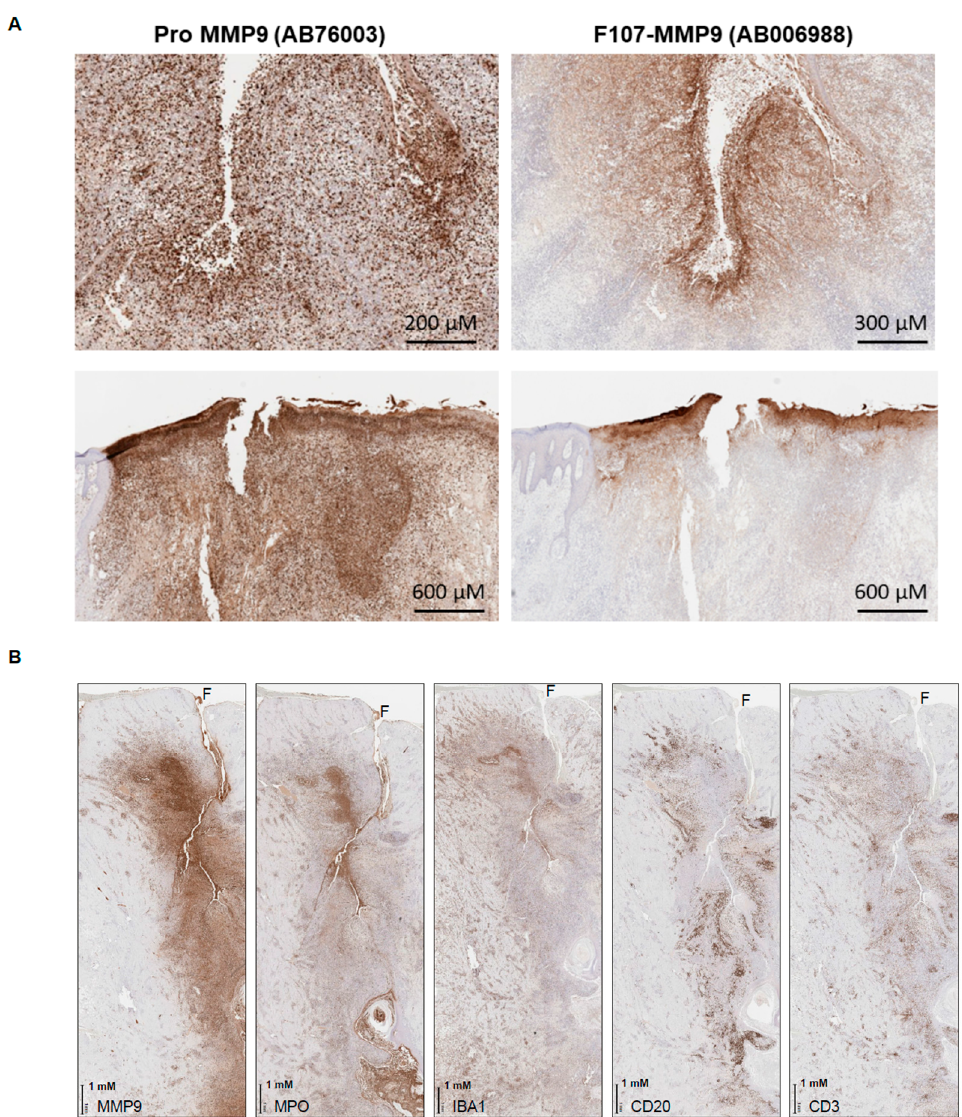
Figure 4. Pro- and active MMP9 in hidradenitis skin specimens. ( A ) Pro-MMP9 is widespread in the skin of patients with hidradenitis, while active MMP9 is more focal and associated with ruptured epidermis (top) and ruptured hair follicles (bottom). ( B ) Active MMP9 and myeloid cells (MPO+ neutrophils and IBA1+ macrophages) are found proximal to the rupture in the skin, while lymphocytes (CD20+ B cells and CD3+ T cells) are secondary. F, fistula; IBA1, anti-ionized calcium- binding adaptor protein-1; MMP, matrix metalloproteinase; MPO, myeloperoxidase.